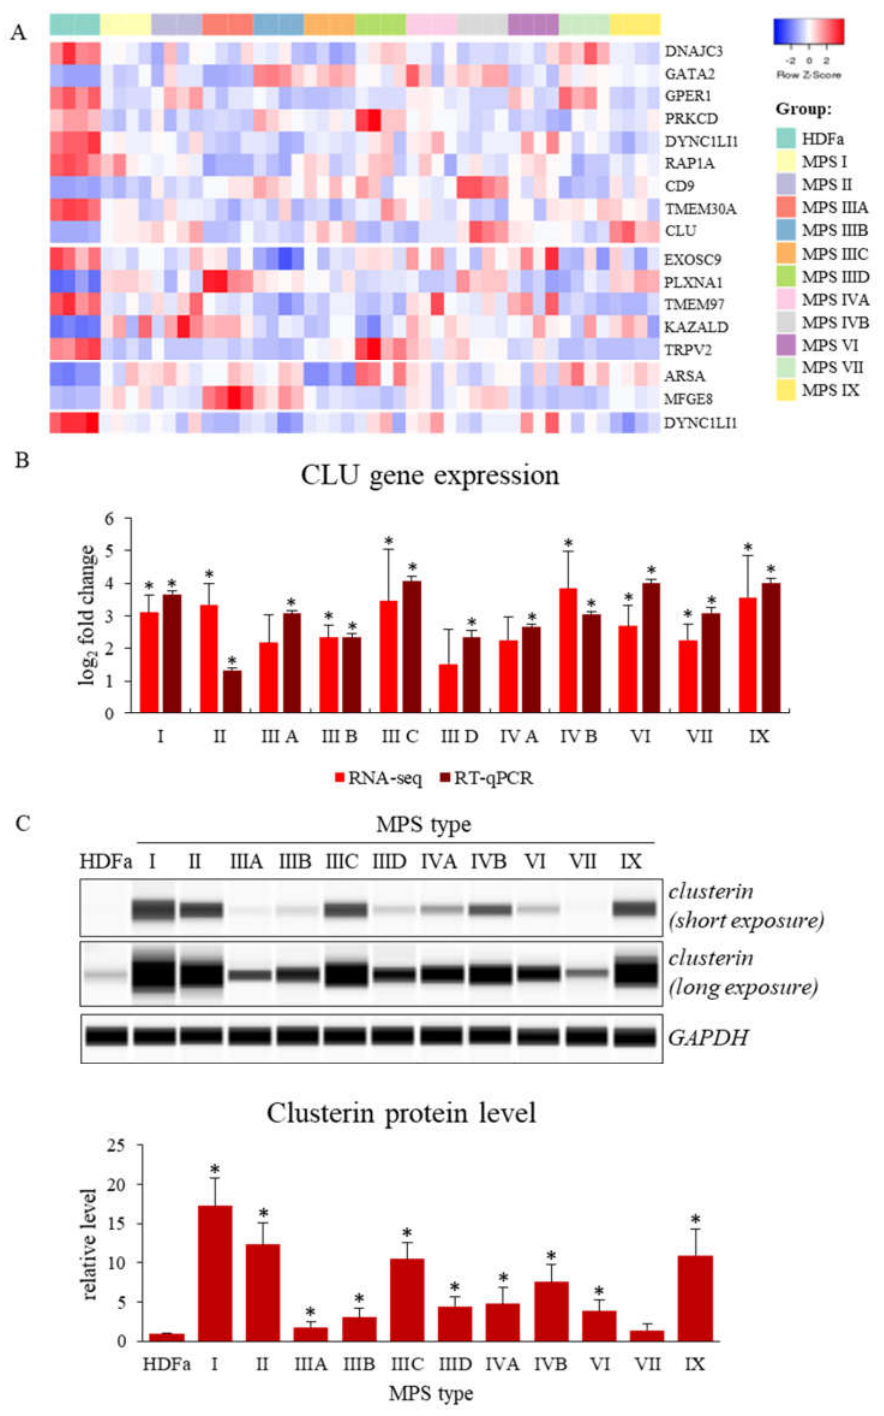
Figure 1. Genes with changed expression levels in at least six types/subtypes of MPS relative to HDFa cells which take part in cell activation, growth, division and recognition processes (according QuickGO database) ( A ), and levels of expression of the CLU gene analyzed by either RNA-seq and real-time PCR techniques ( B ) or Western-blotting ( C ) (representative blot and quantitative densitometric analysis). Presented results constitute the mean values of 4, 3 and 3 independent experiments, for RNA-seq, RT-qPCR, and Western-blotting, respectively). Error bars indicate standard deviation. Statistically significant differences compared to the results obtained for HDFa cells are indicated by an asterisk (*).